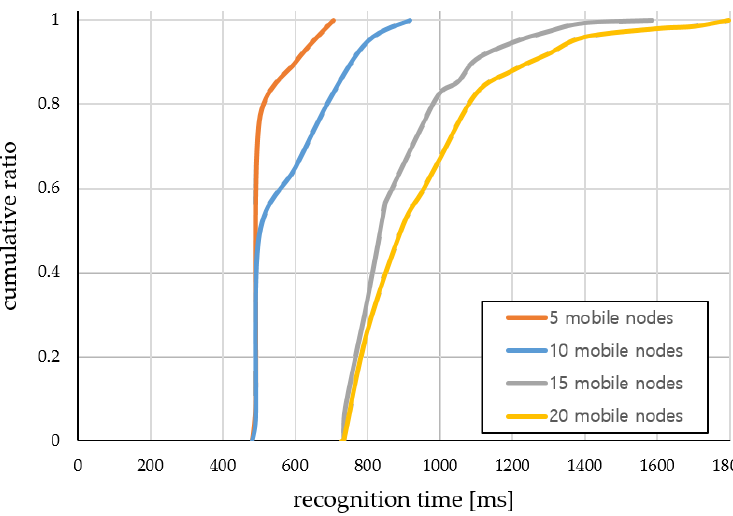
Figure 12. Recognition time according to the number of mobile nodes increments of 5 (Experiment 3).